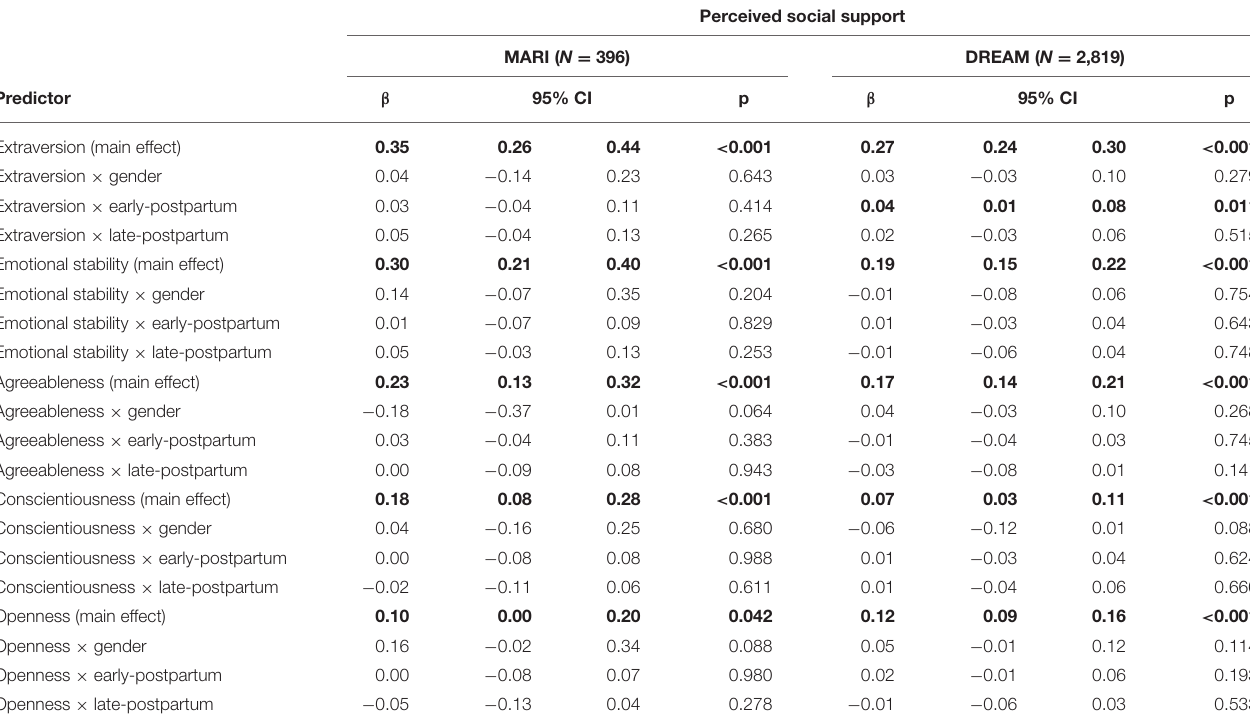
TABLE 6 | Associations of the Big Five personality traits with peripartum (changes in) perceived social support in MARI ( N = 396) and DREAM ( N = 2,819).